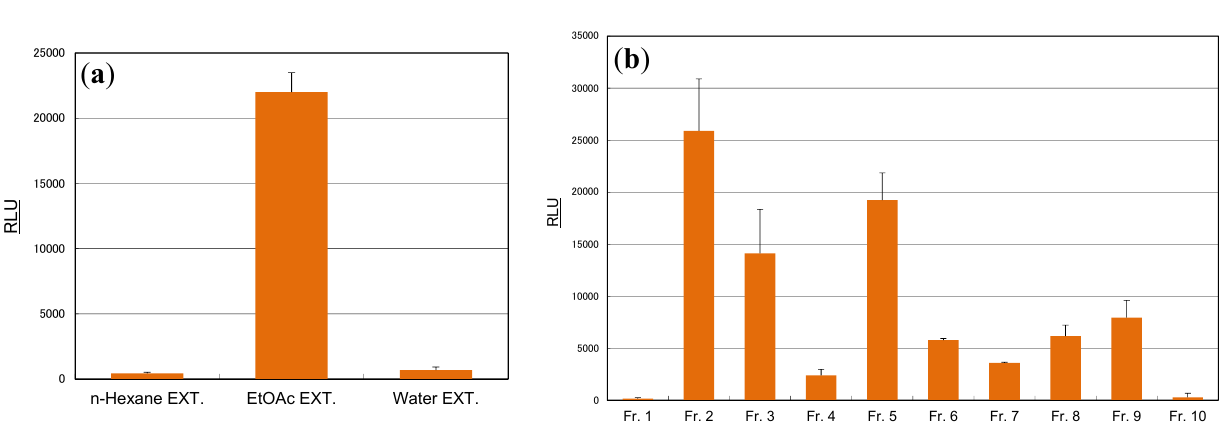
( a ) Extracts from cassia seed. ( b ) Fractions from ethyl acetate extracts. Sample extracts were used at a final concentration of 100 μ g/mL. Results are expressed as means ±